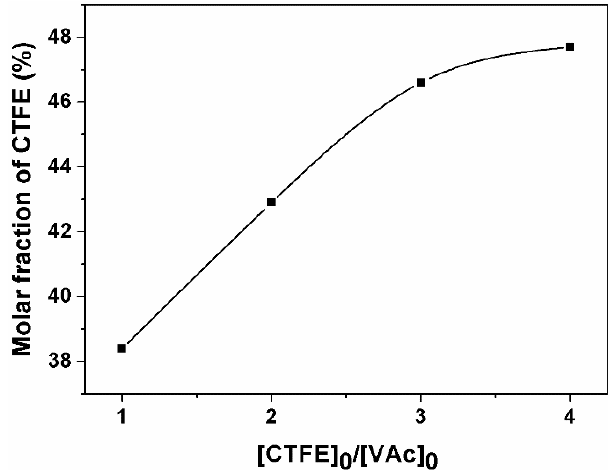
Figure 1. Molar content of CTFE in the copolymer as a function of the initial molar ratio of CTFE to VAc (Sample P1, P2, P3, and P4).